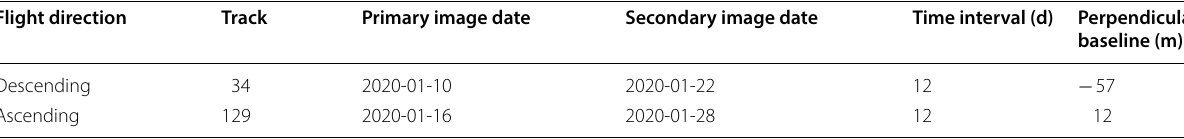
Table 2 Information of the Sentinel-1 images used for Jiashi earthquake Flight